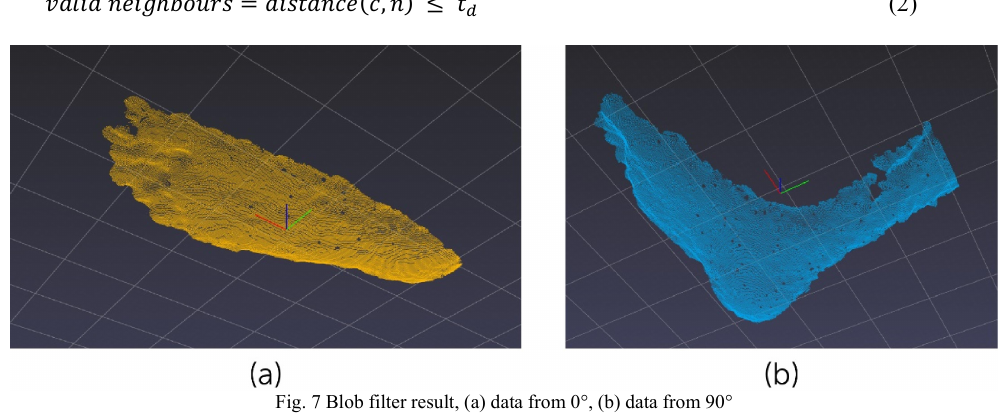
Fig. 7 Blob filter result, (a) data from 0°, (b) data from